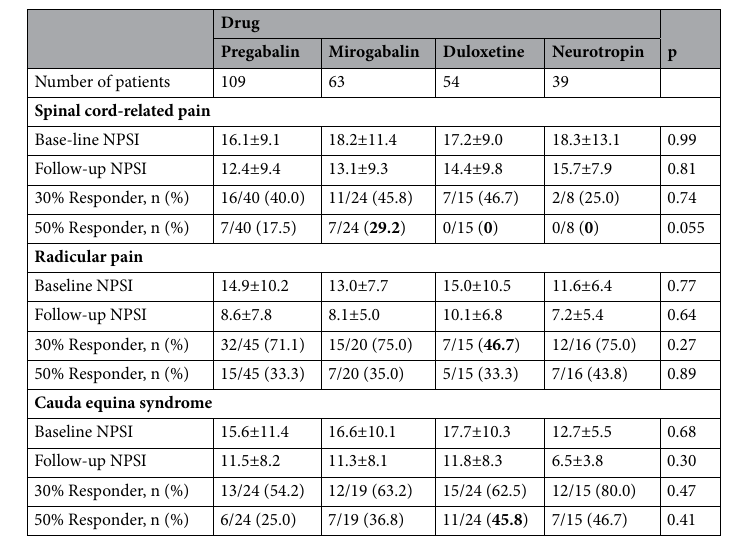
Table 4. The efficacy of each drug, evaluated by using the neurological symptoms of neuropathic pain related to spinal disorders. Data are shown as the mean ± the standard deviation. Bold, notable results. ⁑ p<0.01, compared to total patients with radicular pain and cauda equina syndrome. NPSI Neuropathic Pain Symptom Inventory.